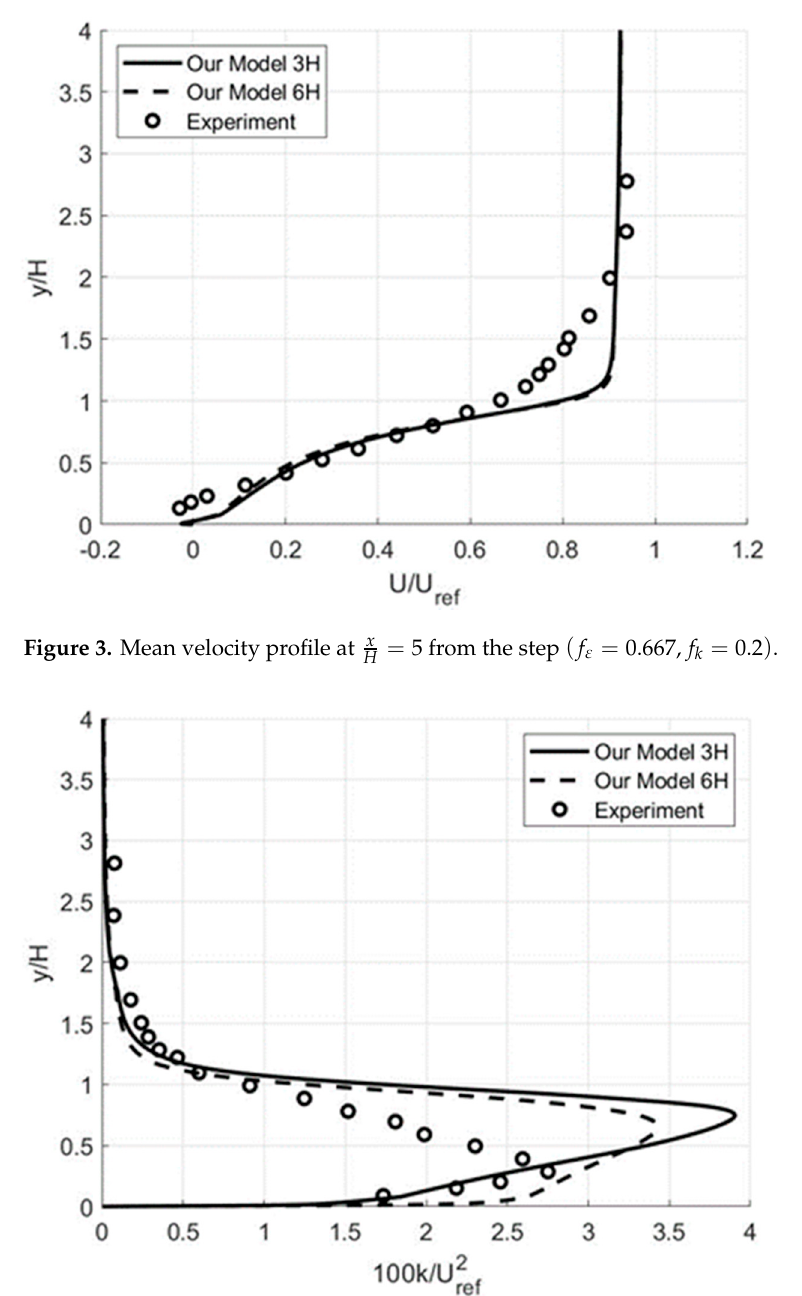
x = 5 from the step ( f ε = 0.667, f = 5 from the step (𝑓 (cid:3084) = 0.667,𝑓 (cid:3038) = 0.2). Figure 4. Mean kinetic energy profiles at H (cid:3009) = 5 from the step (𝑓 (cid:3084) = 0.667,𝑓 (cid:3038) = 0.2). (cid:3009)